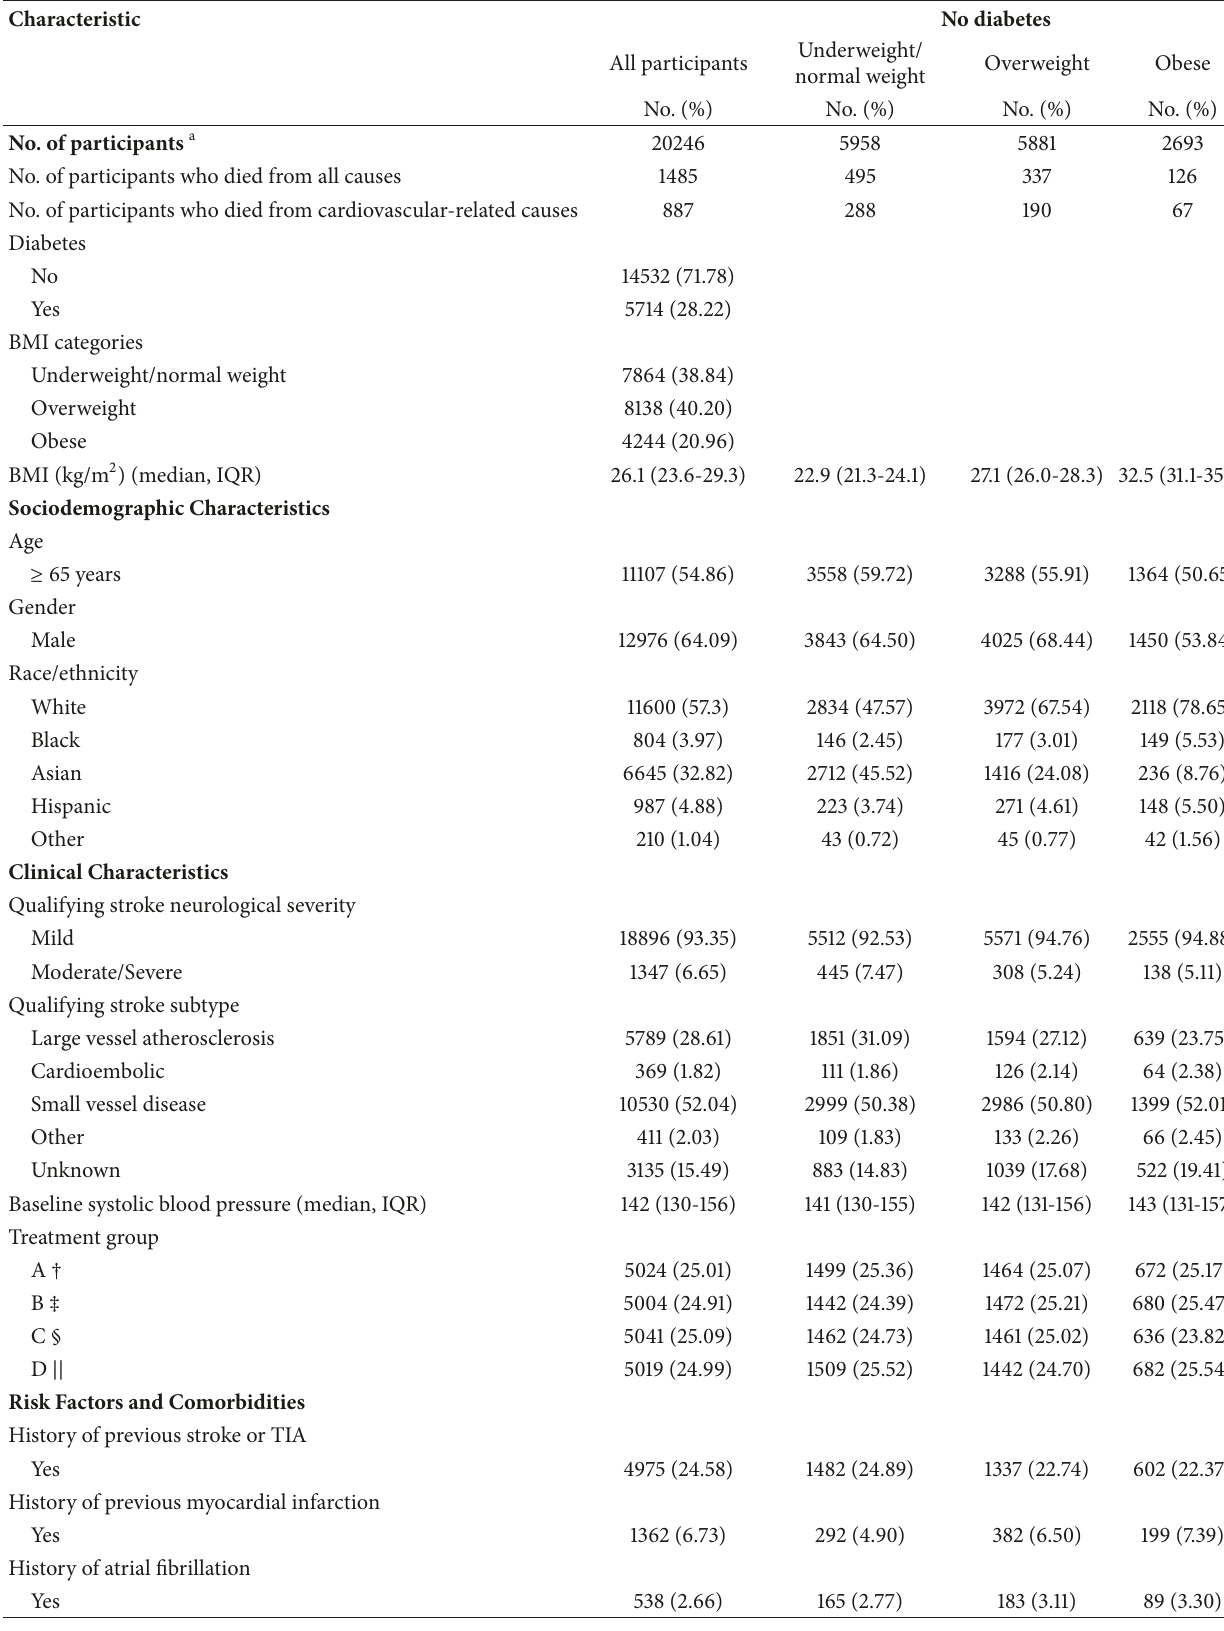
Table 2: Baseline characteristics of 20,246 ischemic stroke survivors based on BMI categories and diabetes, the PRoFESS trial.